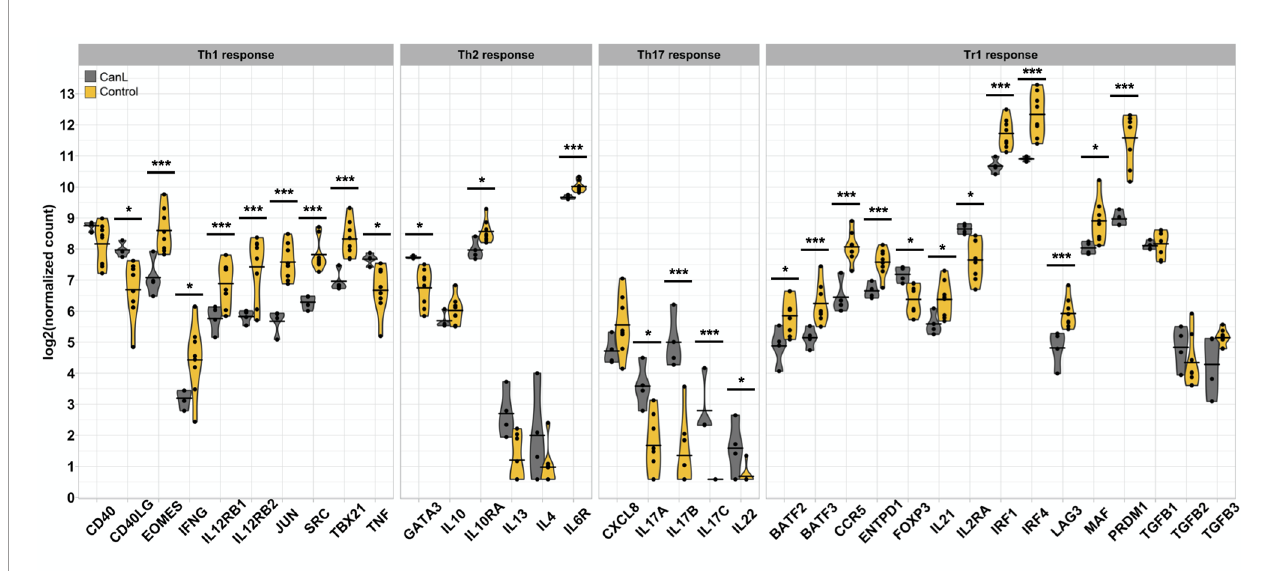
FIGURE 4 | Th1, Th2, Th17, Tr1 gene expression signatures observed in the lymph nodes. Violin and dot plots of selected genes involved in Th1, Th2, Th17 and Tr1 immune responses during canine leishmaniosis. *p-value <0.05, **p-value <0.01, ***p-value